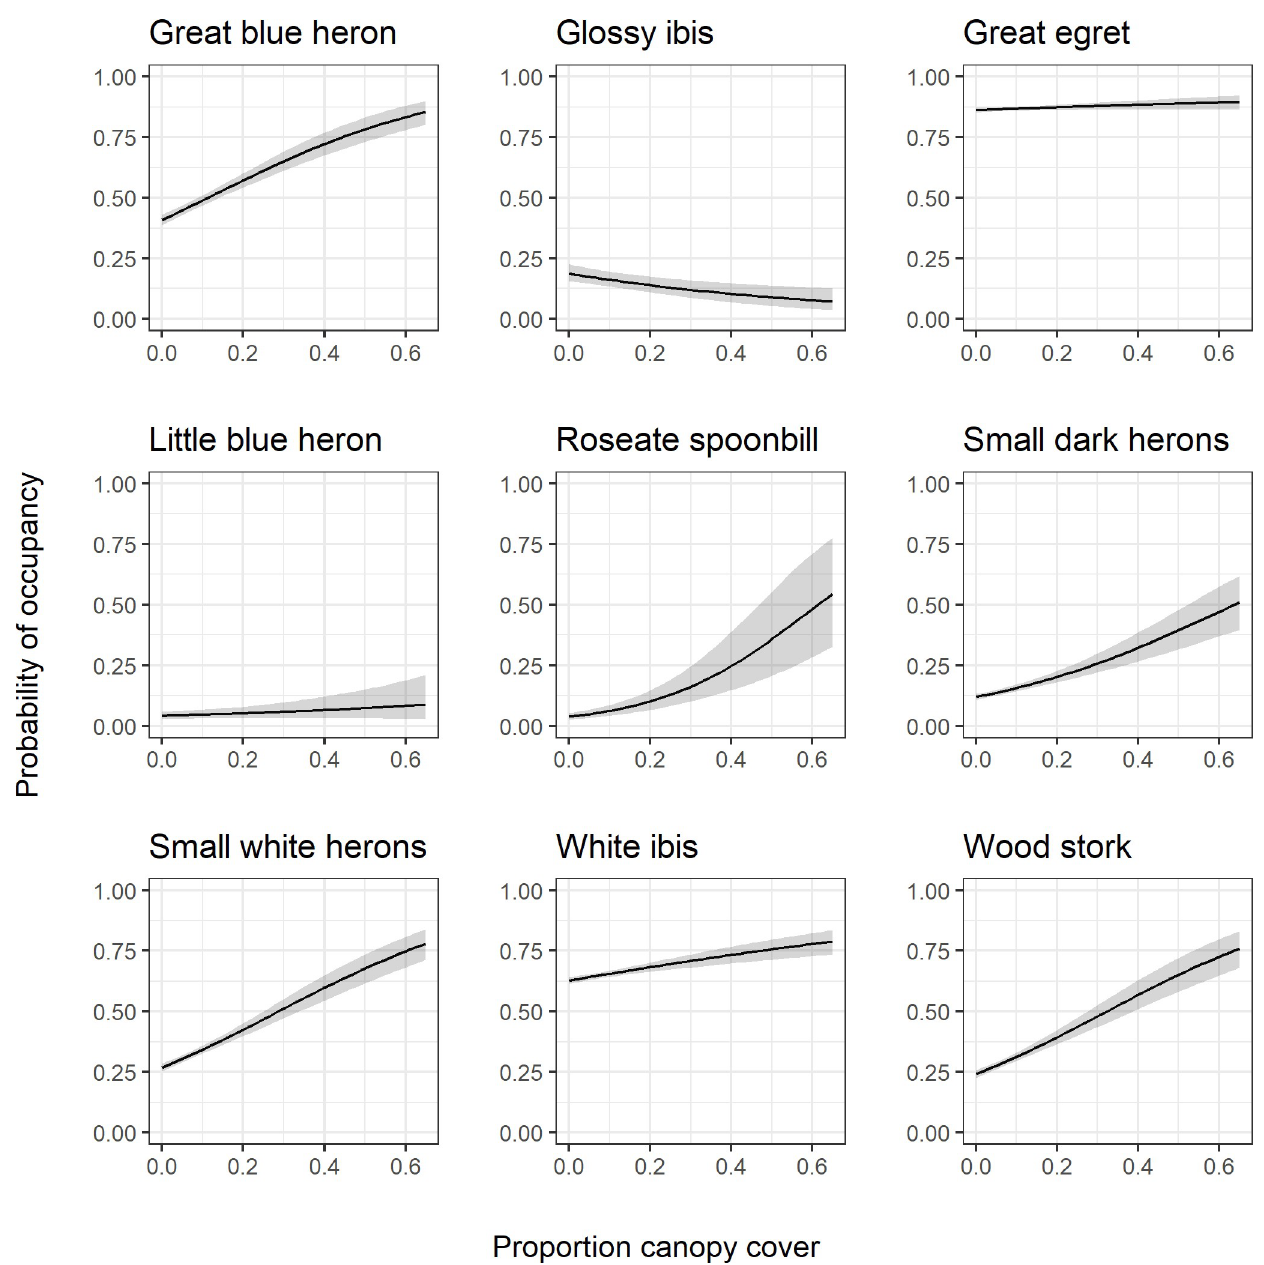
Fig 8. Canopy cover response curves. Species-specific relationships between probability of occupancy and proportion tree canopy cover fitted joint species distribution model of wading birds. Responses are calculated with all other model variables held at their mean. The black line represents the posterior mean and the gray shading represents the 95% posterior